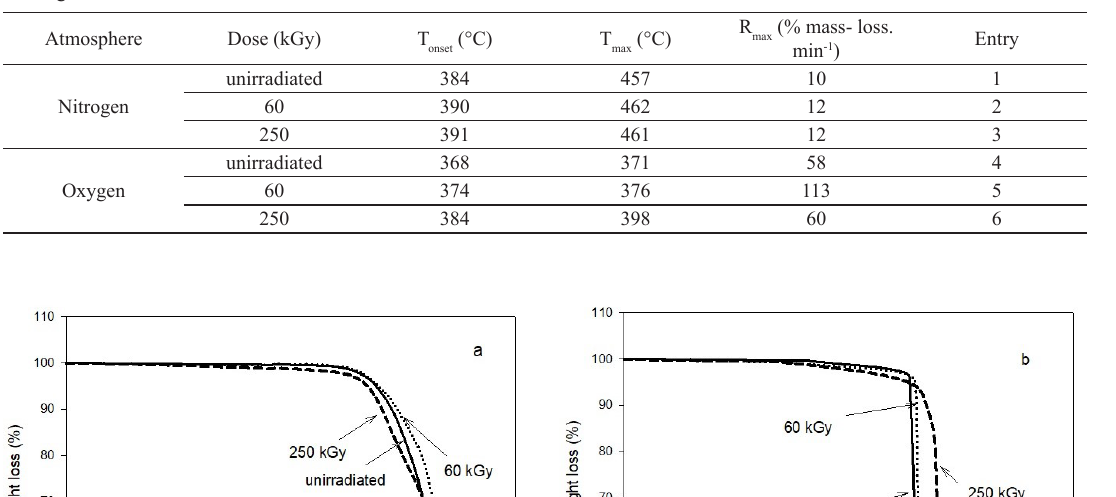
or N atmospheres. 2 2